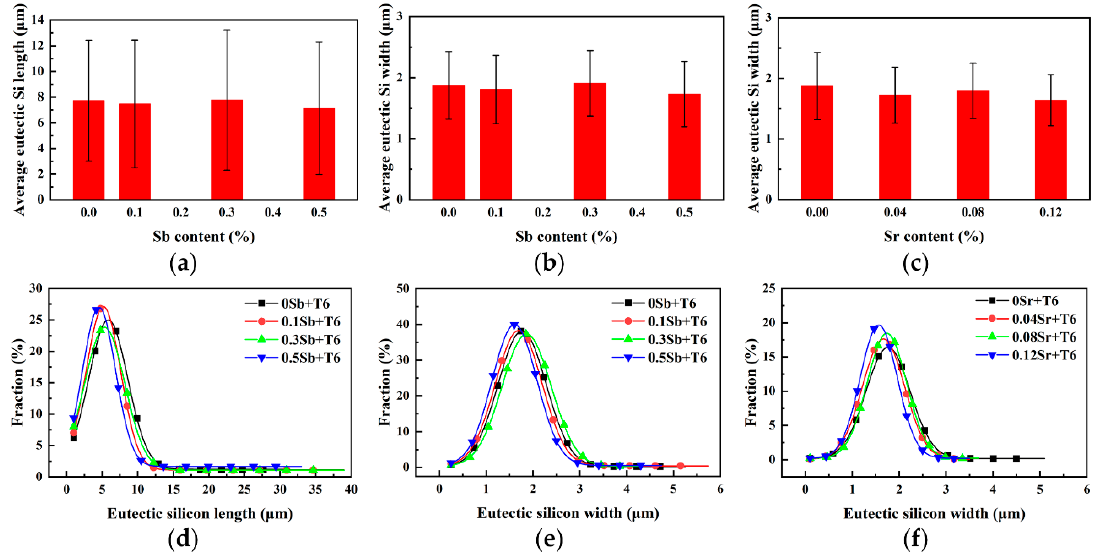
Figure 4. Distribution and variation of eutectic silicon size in Al-8Si alloys with the addition of different modifiers after T6 heat treatment: ( a ) variation of length after Sb modified, ( b ) variation of width after Sb modified, ( c ) variation of width after Sr modified, ( d,e ) distribution of size after Sb modified, ( f ) distribution of size after Sr modified.